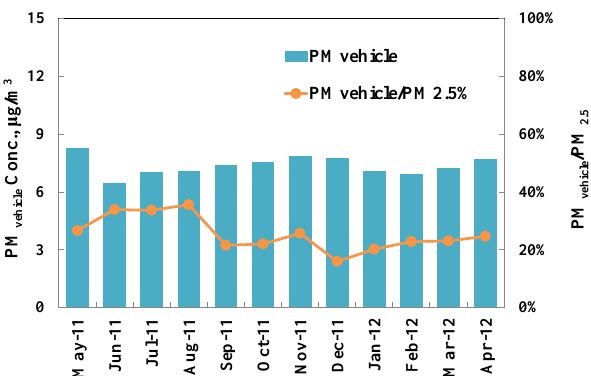
Figure 6 . Monthly average vehicle-related PM 2.5 concentrations estimated by (OM vehicle +EC) Figure 6. Monthly average vehicle-related PM 2 . 5 concentrations estimated by (OM vehicle + EC) and the relative contributions to the and the relative contributions to the monthly average PM 2.5 mass at MK AQMS during May monthly average PM 2 . 5 mass at MK AQMS during May 2011– 2011–April 2012. (Note: PM 2.5 mass concentrations were measured by a Tapered Element April 2012. (Note: PM 2 . 5 mass concentrations were measured by a tapered element oscillating microbalance (TEOM 1400AB) on an Oscillating Microbalance (TEOM 1400AB) on an hourly basis.) hourly